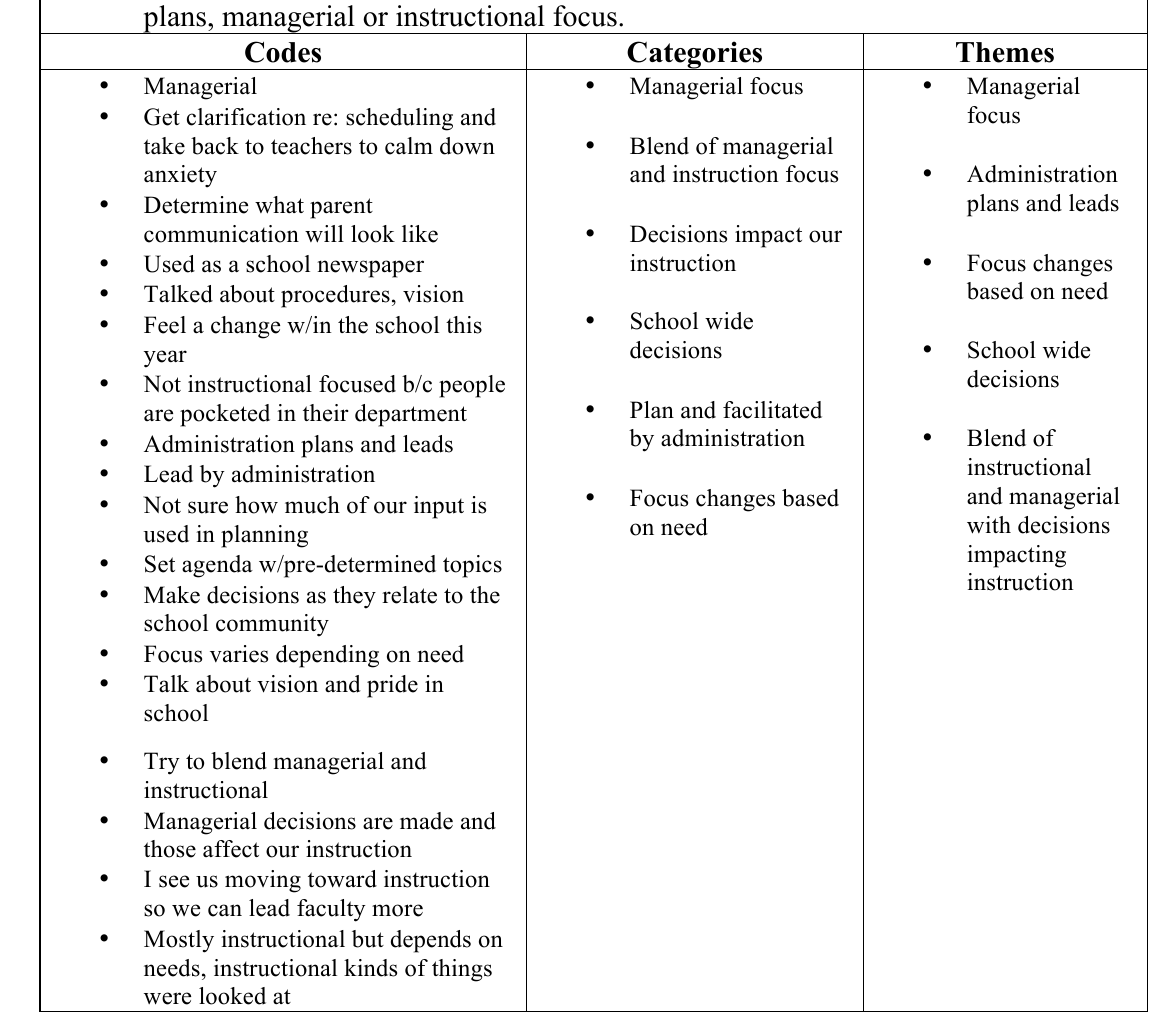
Leadership Team Members’ Question Nine and